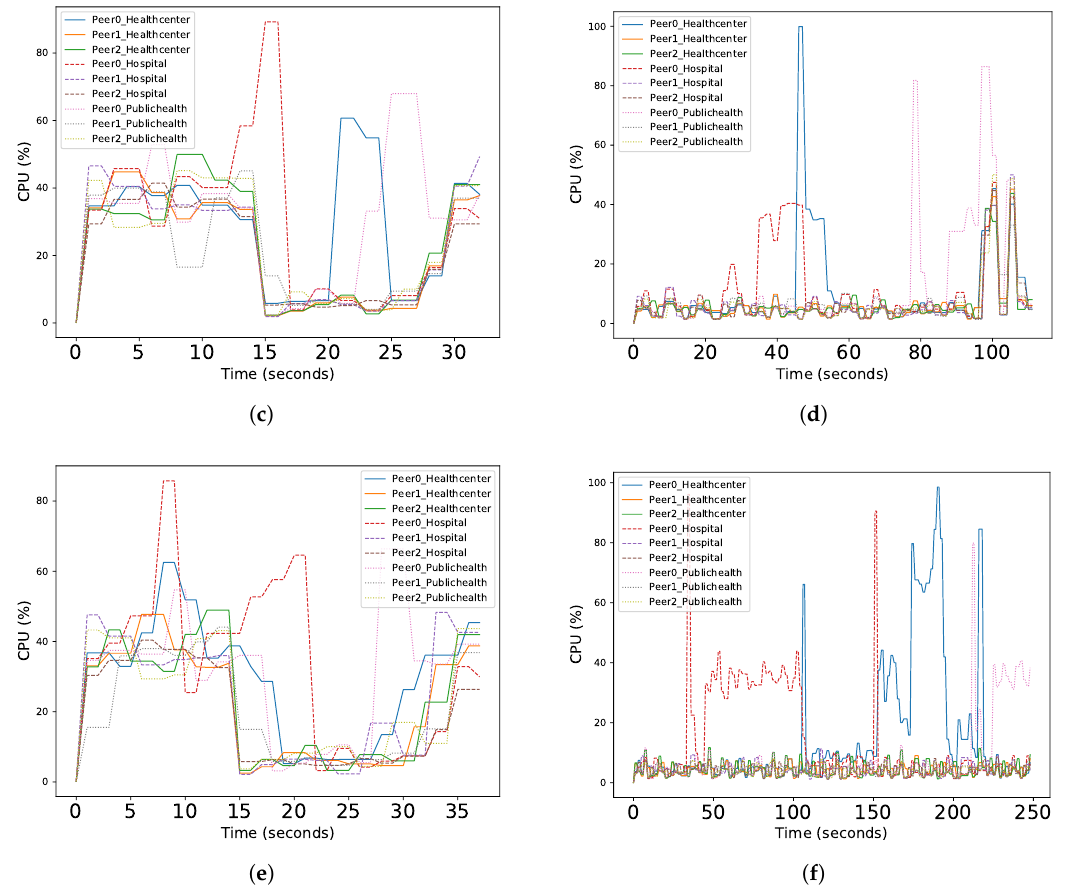
Figure 5. ( a ) Read queries workflow on 1000 Records. ( b ) Write queries workflow on 1000 Records. ( c ) Read queries workflow on 10,000 Records. ( d ) Write queries workflow on 10,000 Records. ( e ) Read queries workflow on 100,000 Records. ( f ) Write queries workflow on 100,000 Records. CPU Usage (%) of blockchain peers during